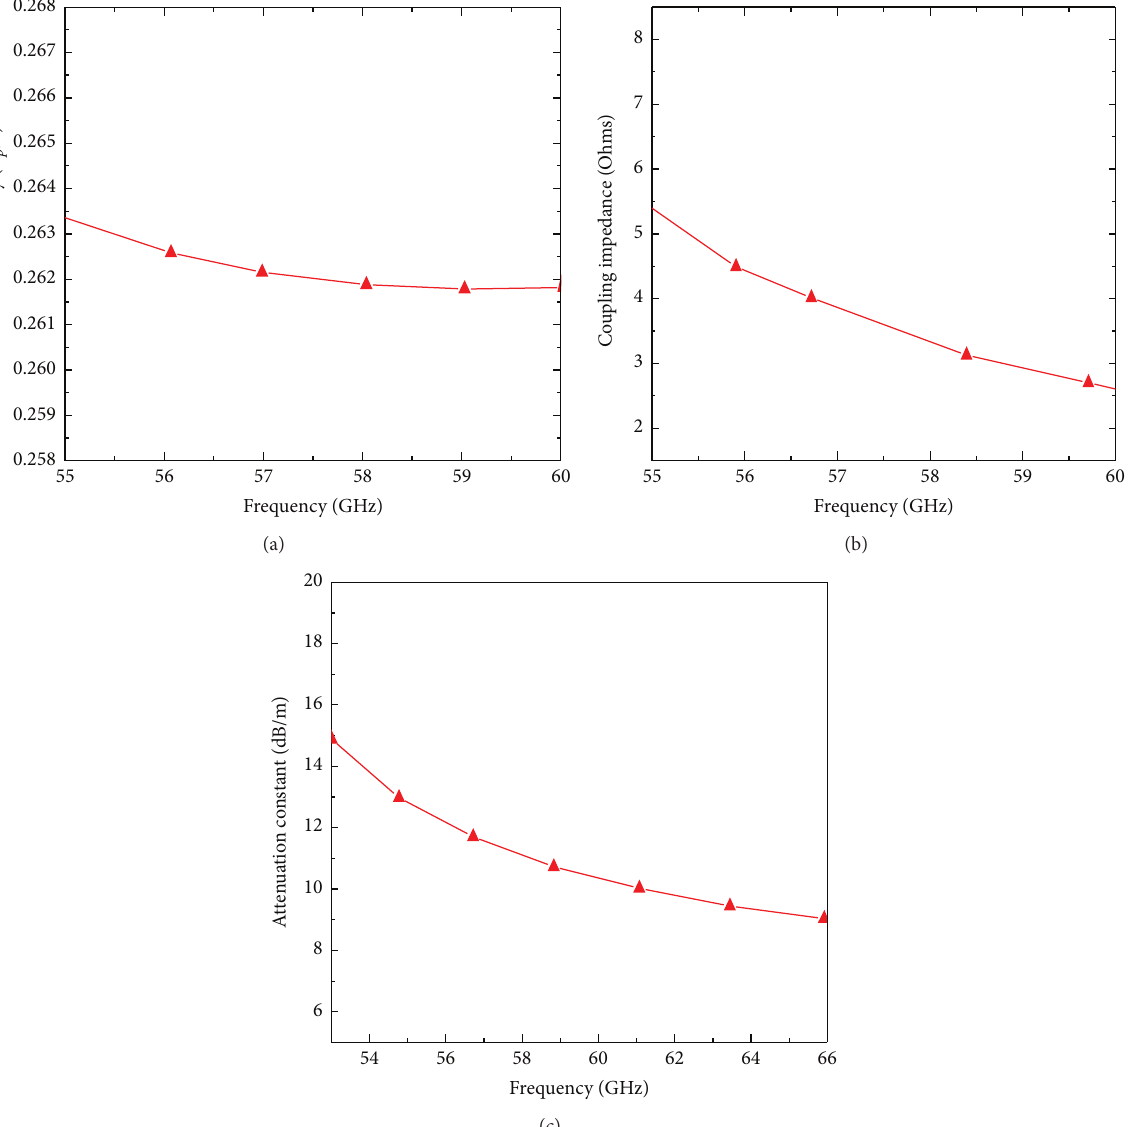
Figure 8: (a) Dispersion curve, (b) coupling impedance, and (c) attenuation constant for FWG SWS.